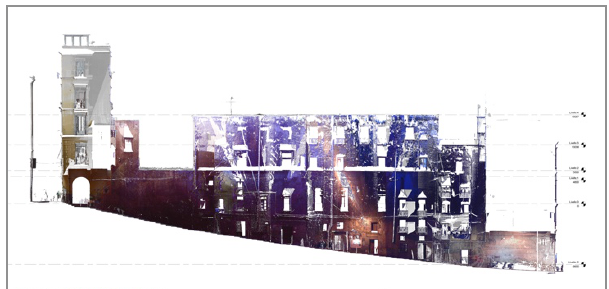
Figure 4. Palazzo Penne, elevation view. Pointcloud in Autodesk Revit. Processing: C. Tarantino, M.